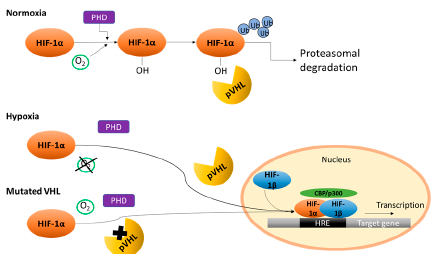
Figure 1. Regulation of HIF1 α under normoxia and hypoxia conditions. Under normoxia conditions, the prolyl hydroxylase domain (PHD) hydroxylates HIF1 α via molecular oxygen. Hydroxylated HIF1 α becomes polyubiquitylated (Ub) for proteosomal degradation by binding the Von Hippel–Lindau protein (pVHL). Under hypoxic conditions, the activity of PHD is reduced. HIF1 α is directly translocated to the nucleus where it binds HIF1 β and CREB binding protein/p300 (CBP/p300) at the hypoxia response element (HRE) to act as transcription factor. If the VHL gene is mutated, it is not capable to bind HIF1 α . HIF1 α leads to the transcription of the target genes as described under hypoxia